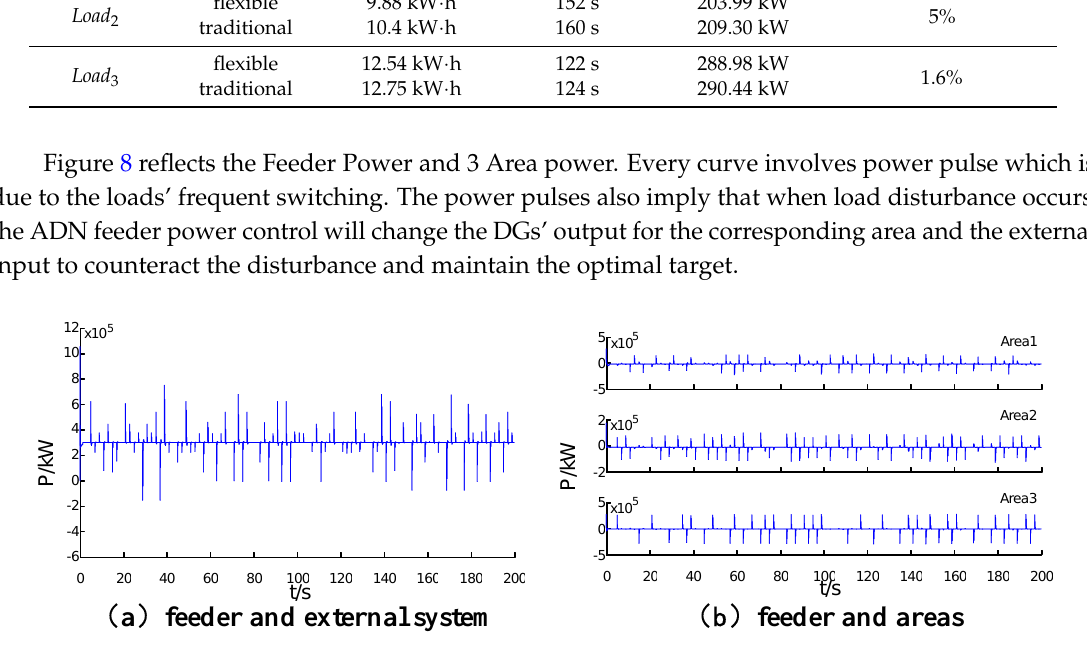
Figure 8. The exchange power of ADN feeder and control areas under normal condition; ( a ) feeder and external system; ( b ) feeder and areas.